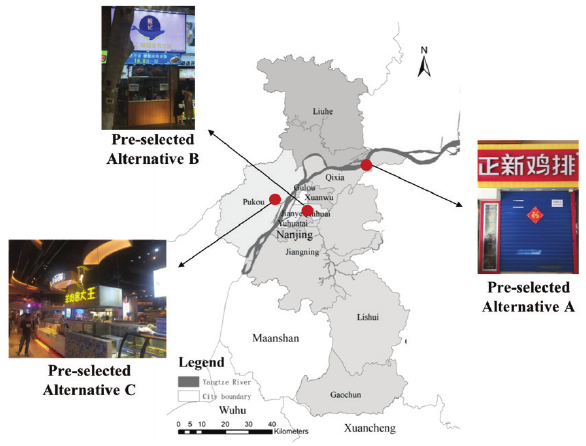
Figure 2. Th e location distribution of three pre-selected alternatives in